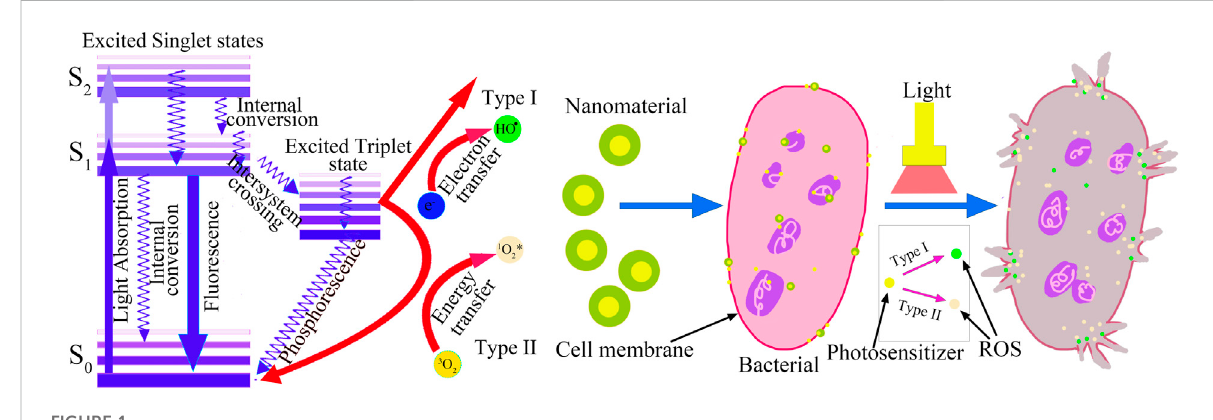
FIGURE 1 Photochemical mechanisms and biological mechanism of